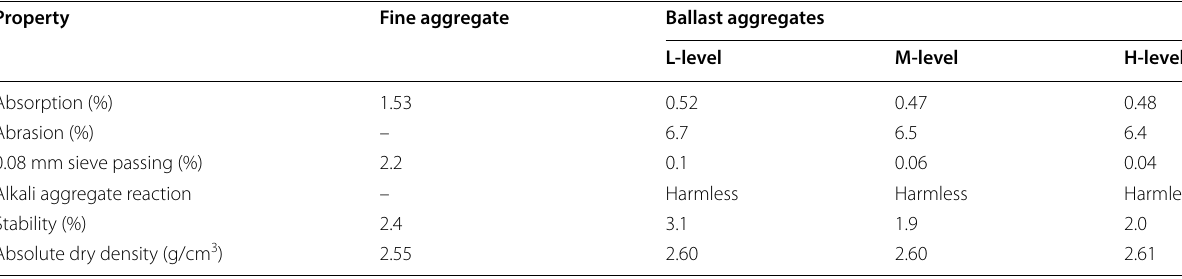
Table 3 Physical and chemical properties of fine and ballast